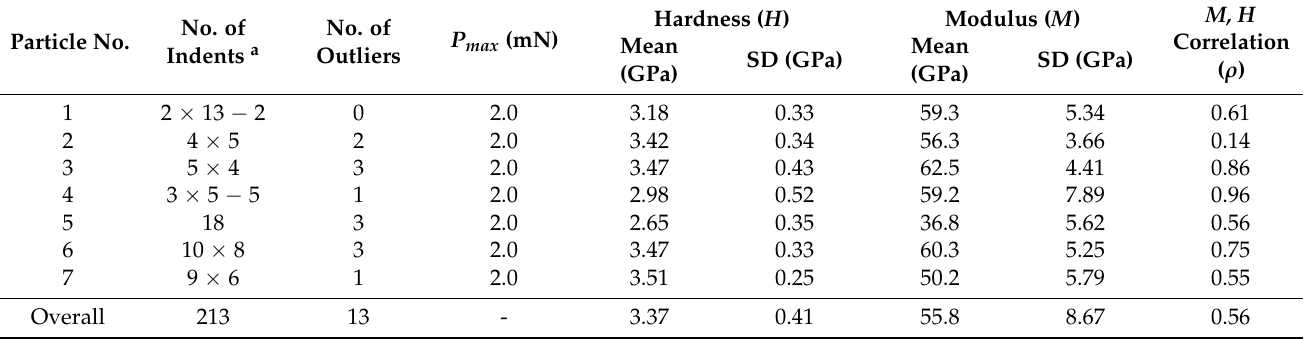
Table 3. Summary of indentation properties of precipitate obtained from baseline EICP